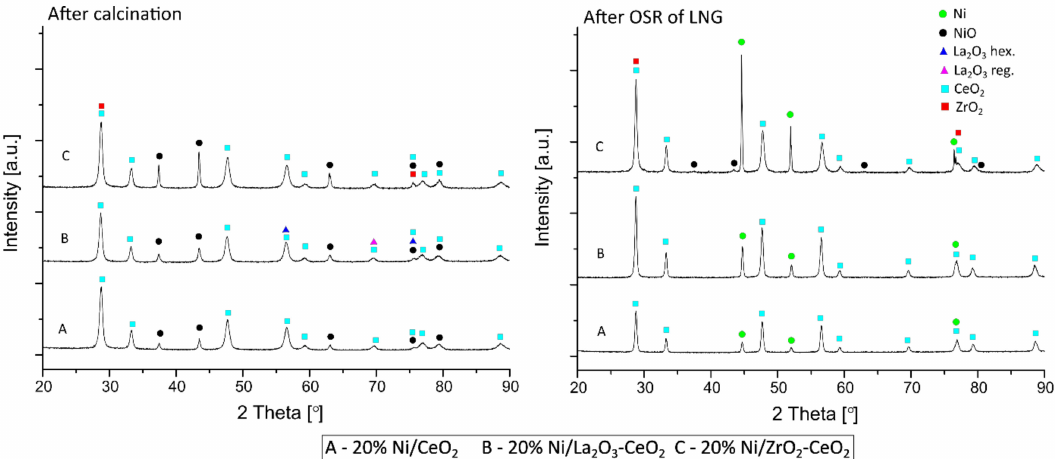
Figure 5. XRD curves of the 20% Ni/CeO 2 , 20% Ni/5% La 2 O 3 –CeO 2 and 20% Ni/5% ZrO 2 –CeO 2 catalysts calcined in an air atmosphere for 4 h at 400 ◦ C and after the oxy-steam reforming of